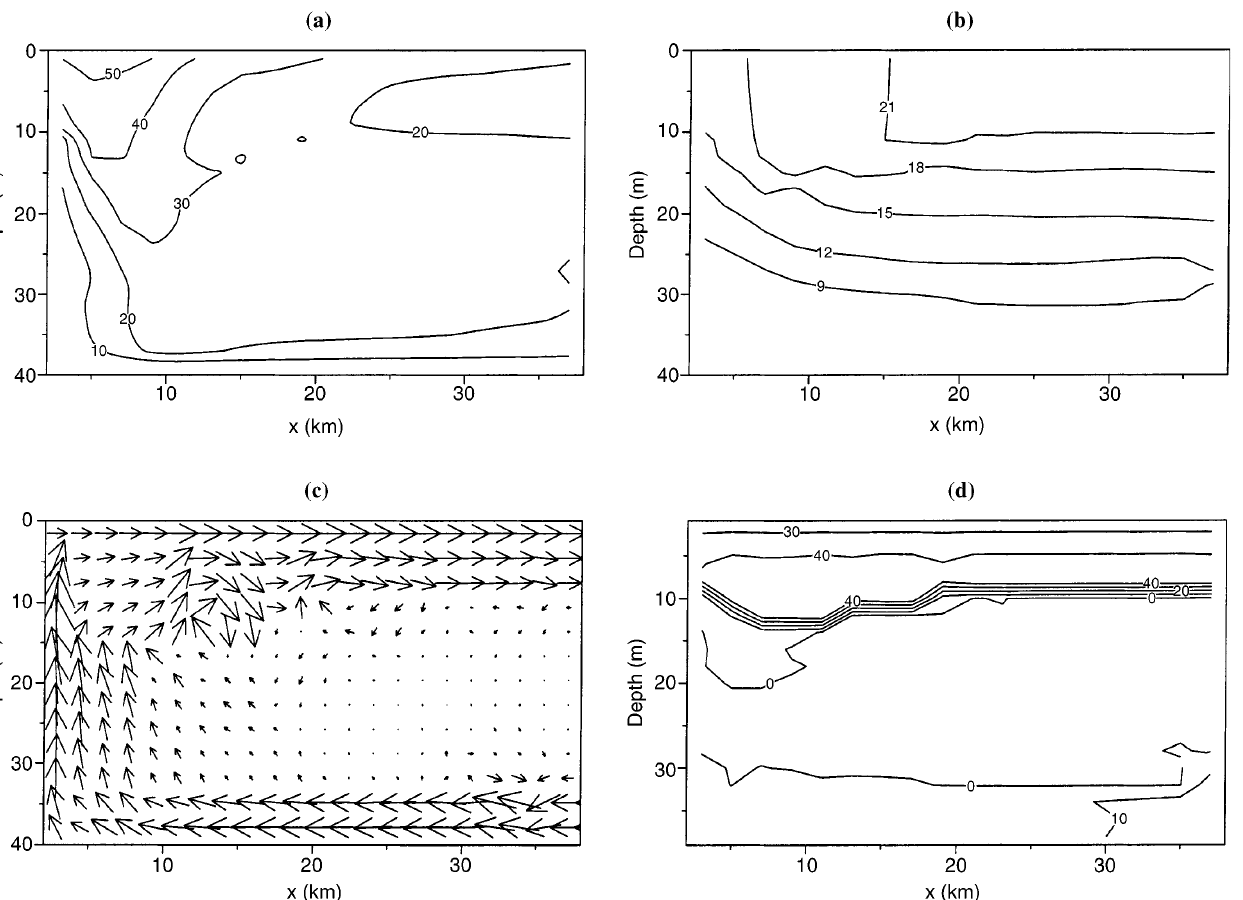
Fig. 10a–d. Optimal solution and optimal turbulent viscosity ob- tained by the assimilation of the temperature data of the coastal upwelling. x (km) is the distance to the coast. a Velocity v (cid:133) cm (cid:1) s (cid:255) 1 (cid:134) , b